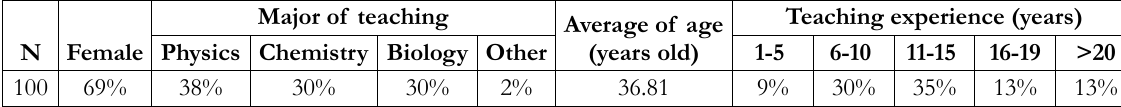
Table 2. Information of sampled in-service